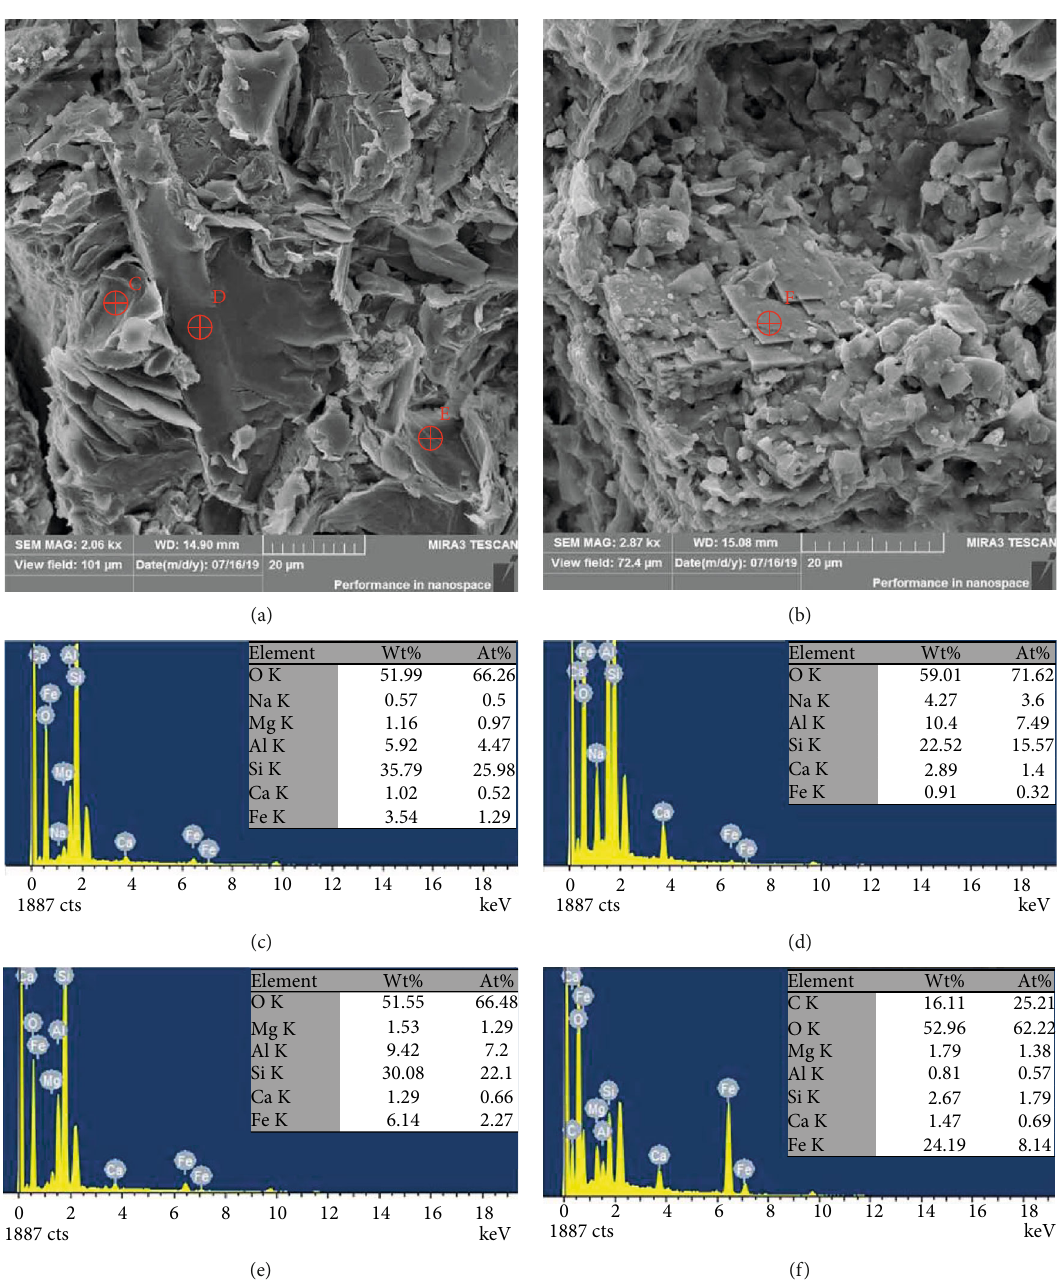
Figure 8: (a, b) SEM images of sample TS5 showing the EDS measurement points. (c – f) EDS patterns at the spots noted in panels (a) and